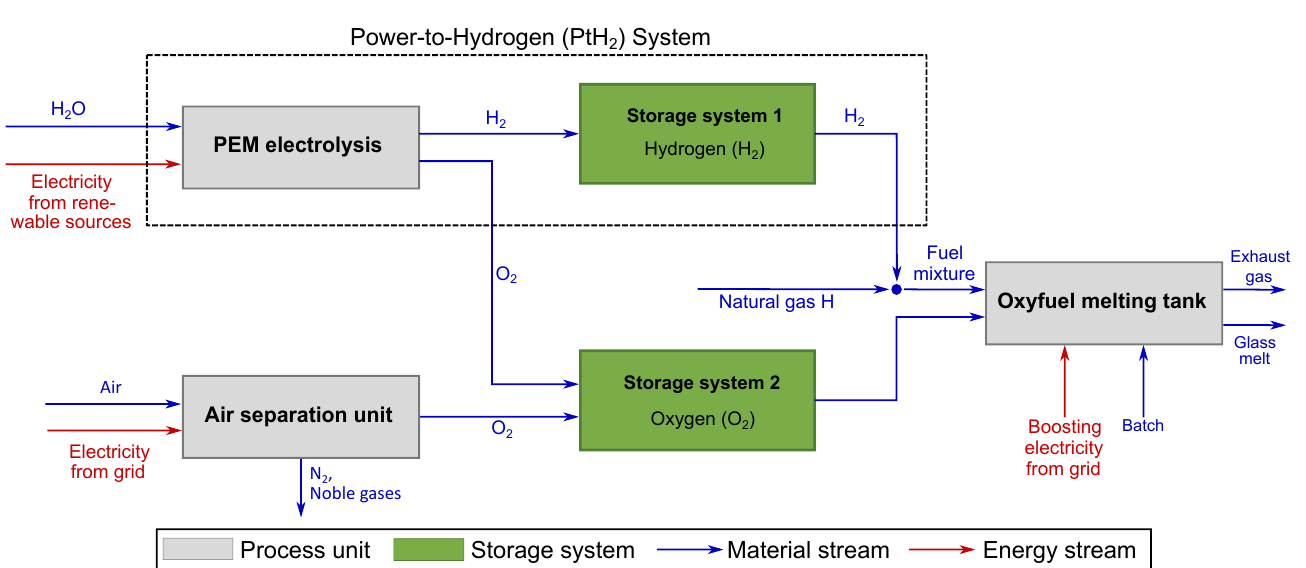
Figure 3. Basic flow sheet for the integration of Power-to-Hydrogen (PtH 2 ) into oxyfuel glass melting processes.